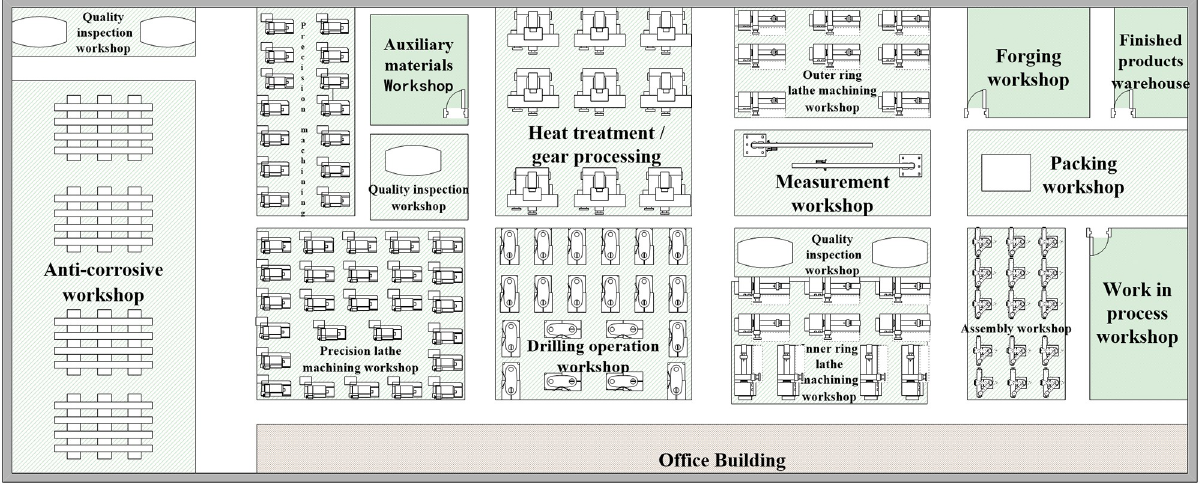
Fig 1. Original layout of the